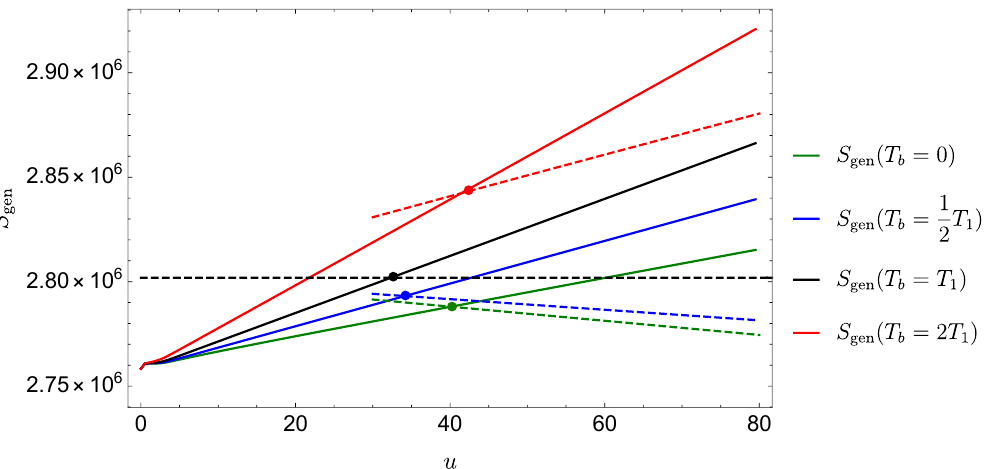
Figure 7 . The Page curve of generalized entropy around Page transition from scrambling phase to late-time phase for different bath temperatures. The solid lines represent the analytical results at the scrambling phase and the dashed lines indicate the numerical results for the late-time phase which are also approximated by solutions (4.26) and their approximate generalized entropy (4.36). Note that the black dashed line shows the generalized entropy at equilibrium case, which is the constant given in eq.